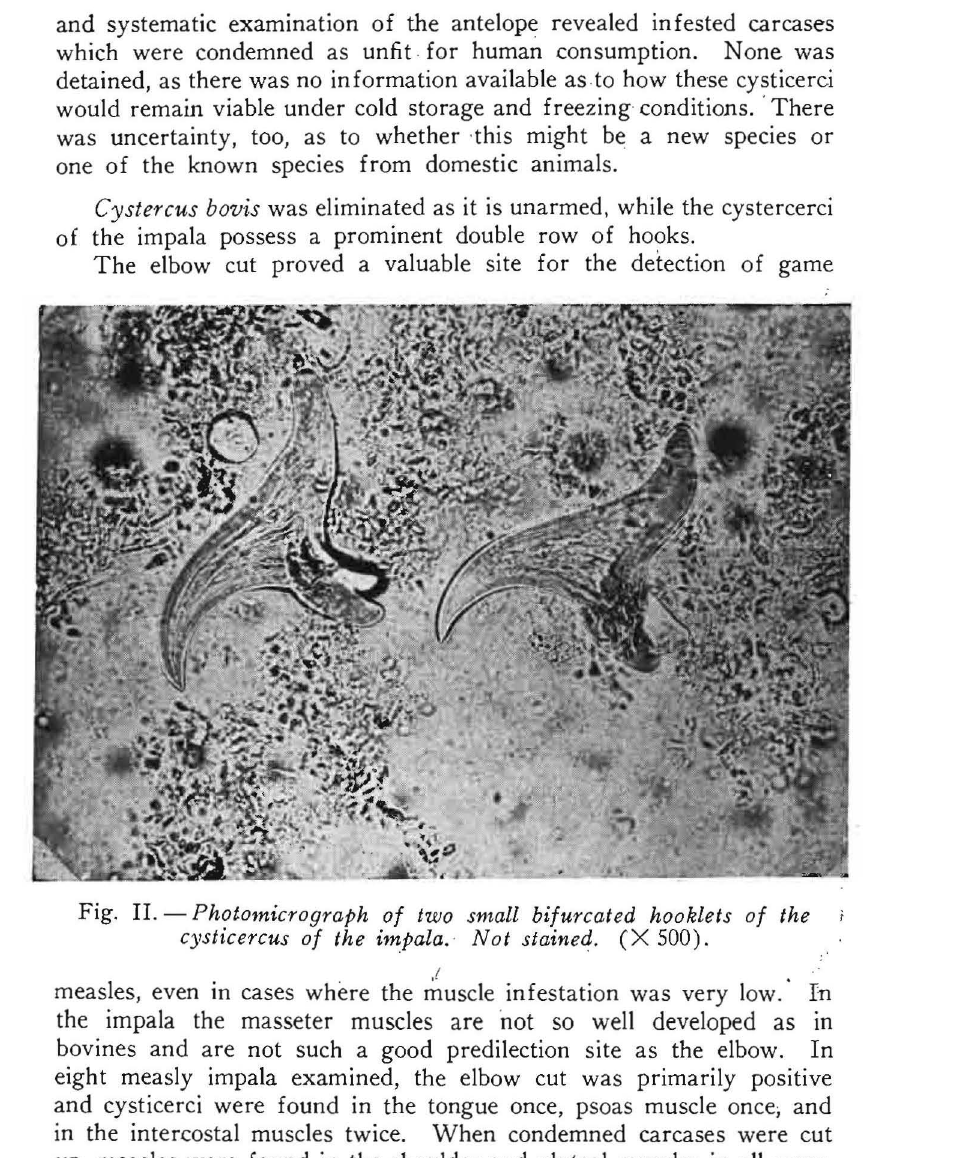
Fig. II. - Photomicrograph of two small bifurcated hooklets of the cysticercus of the impala. Not stained. eX 500).